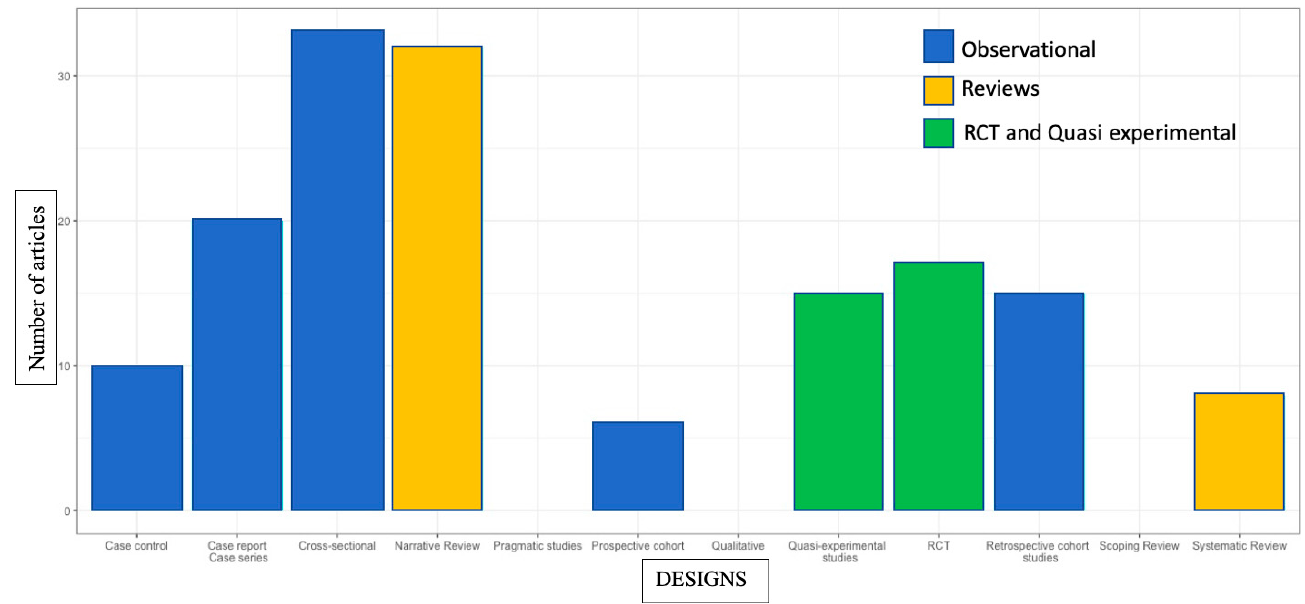
Figure 2. Research designs on proprioceptive cervicogenic dizziness. The number of articles selected by this scoping review is classified by study designs. RCT: randomized control trials.